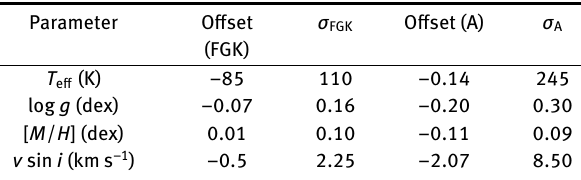
Table 4. Estimation of the offset (signed mean difference) and the errors on the derived parameters for FGK and A